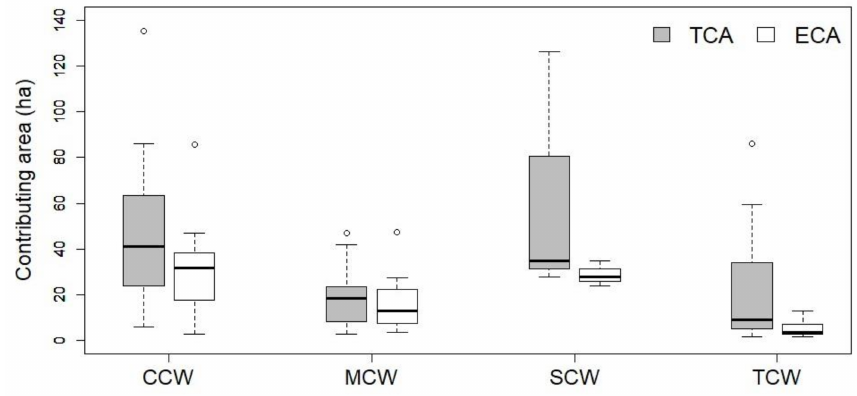
Figure 8. Comparison of size distributions between topographic (TCA) and effective (ECA) contributing areas for each of CCW, MCW, SCW and